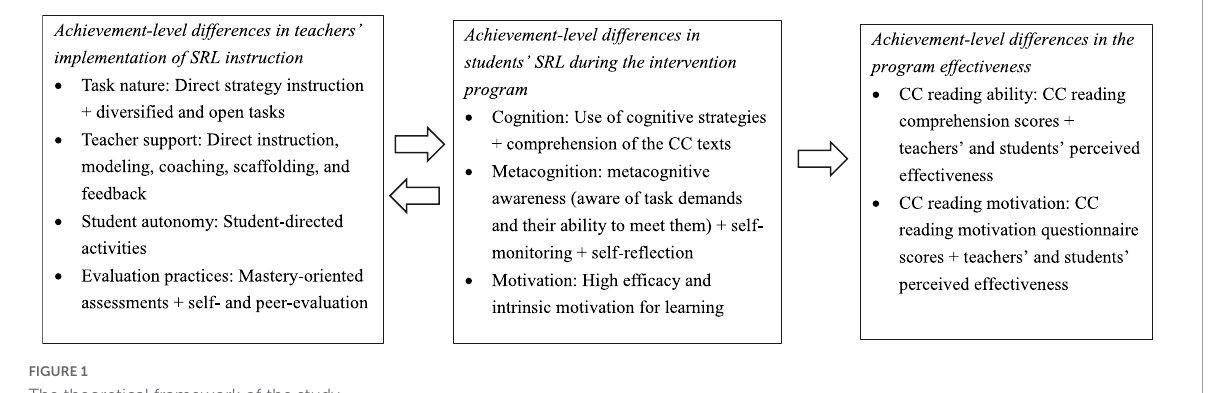
FIGURE1 The theoretical framework of the